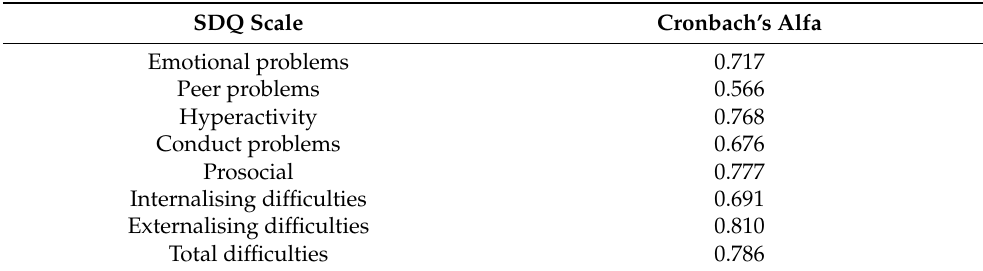
Table 1. Internal consistency statistics (Cronbach’s alfas) of the parent-report version of the SDQ in a clinical population of Latvian children and adolescents.